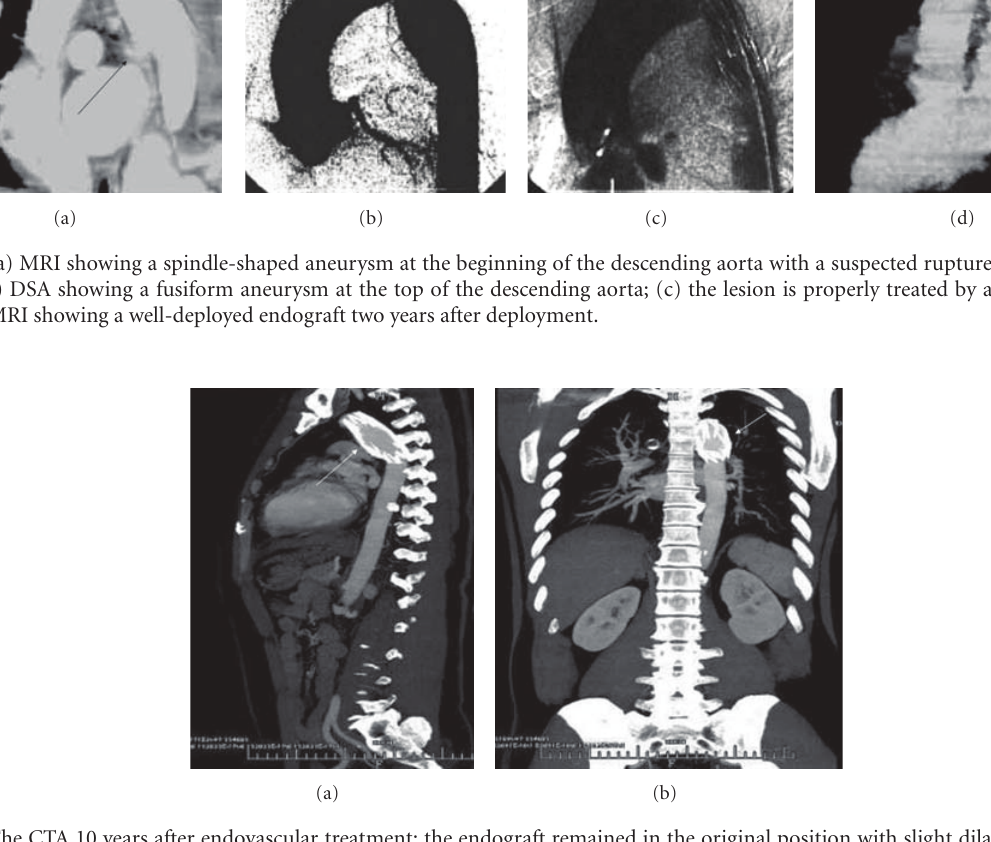
Figure 2: The CTA 10 years after endovascular treatment: the endograft remained in the original position with slight dilation at its center